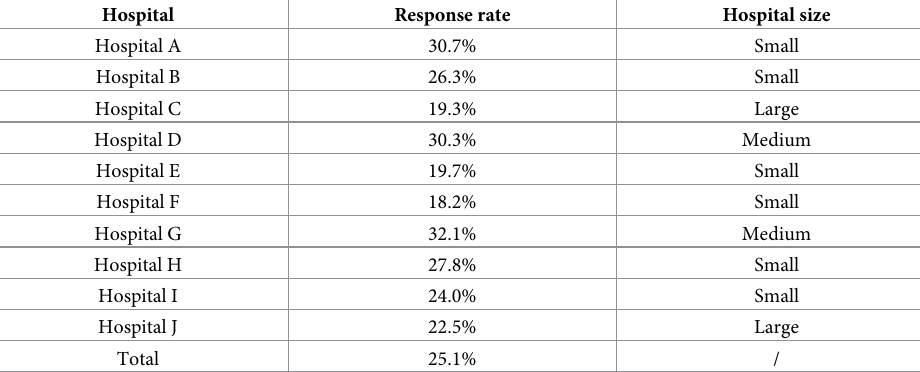
Table 1. Response rate and hospital